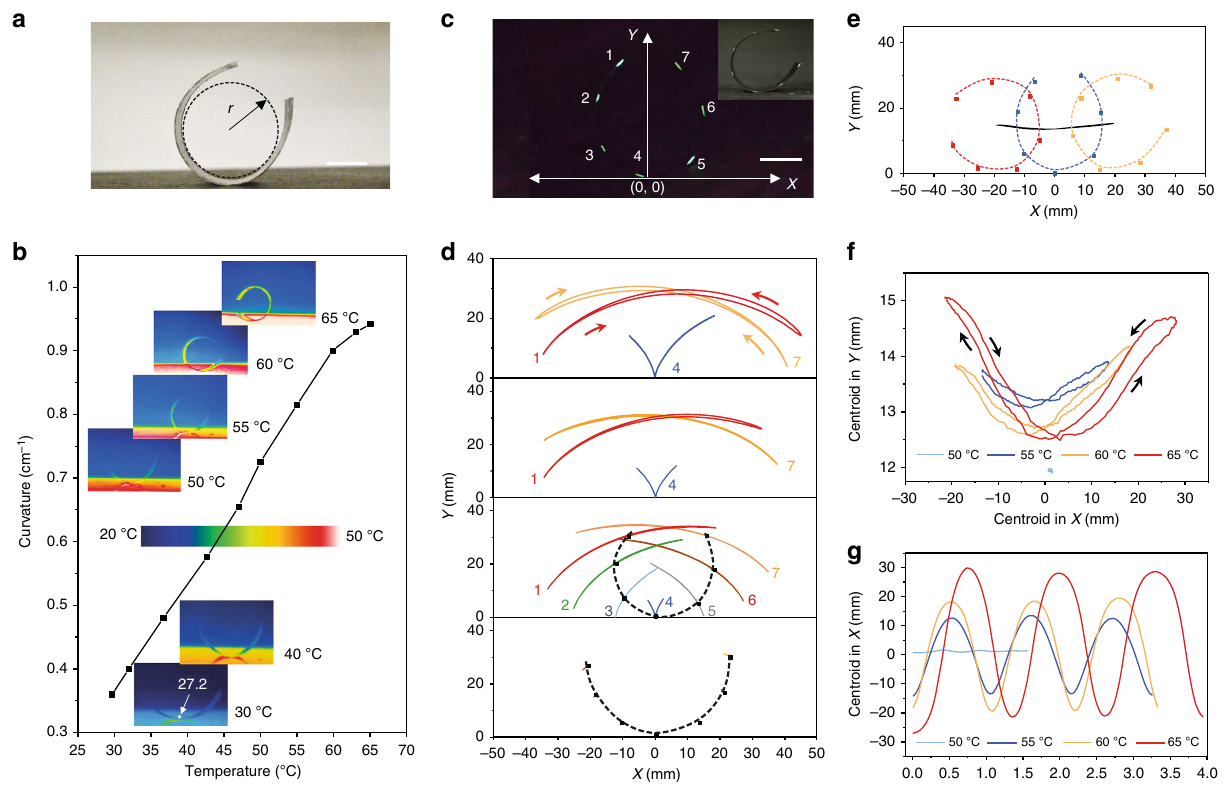
Fig. 2 Autonomous thermo-mechanical oscillation, kinematic tracking, and mechanical analysis. a Photograph of TMES on a hot surface at 60 °C. b Infrared images and curvature change of TMES on the hot surface with different temperatures. c Fluorescent image of marked TMES in UV light and its 2D coordinate system. The inset is a photograph of marked TMES in visible light. d The 2D trajectory of marked points on the cross-section of TMES during a complete oscillation cycle from the leftmost to rightmost and then back to the leftmost position, at four different temperatures, 50, 55, 60, and 65 °C (from bottom to top). e Plot of center of gravity during a complete oscillation cycle based on trajectory of the marked points. f The 2D trajectory of center of gravity at different temperatures. g Time-dependent center of gravity in the x -axis during three consecutive oscillation cycles at different temperatures. All scale bars correspond to 1